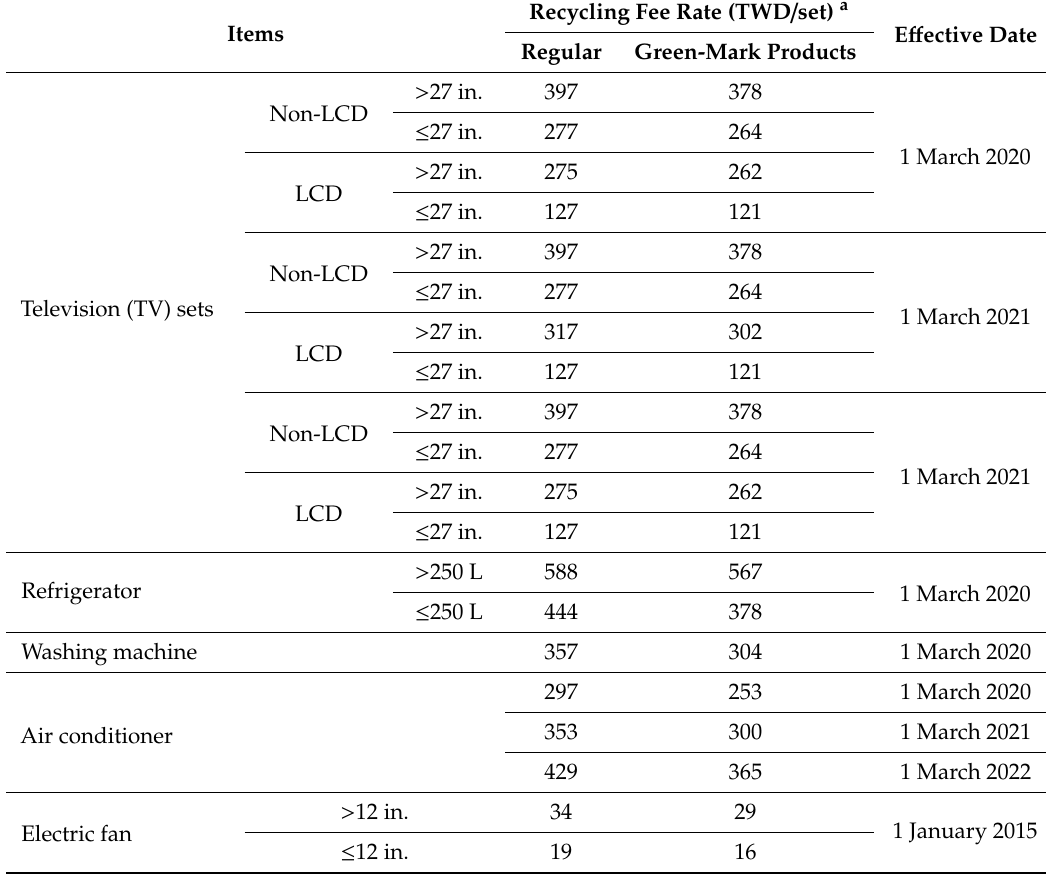
Table 1. Current recycling fee rates of recyclable home electrical appliances in